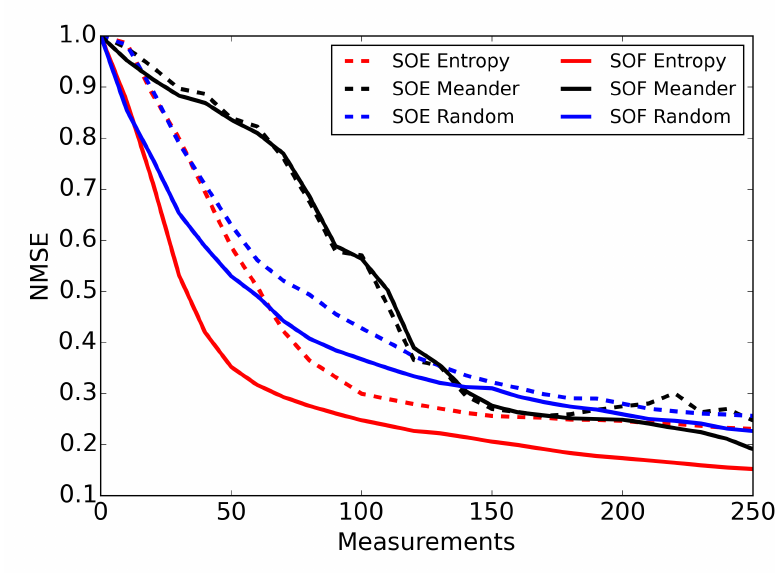
Figure 6. NMSE for SOE (dashed) and SOF (solid) for 10 agents, averaged over 10